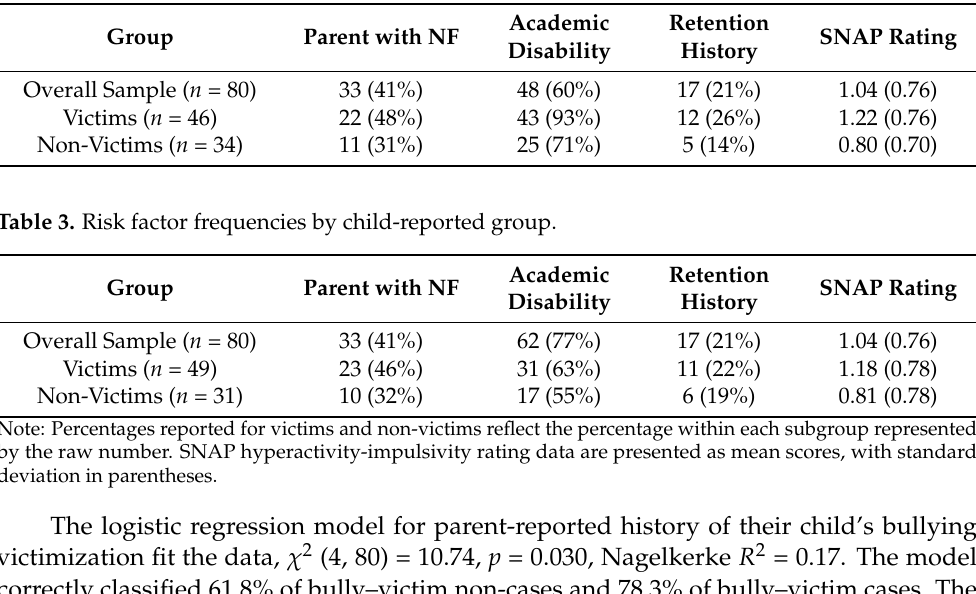
Table 2. Risk factor frequencies by the parent-reported group.